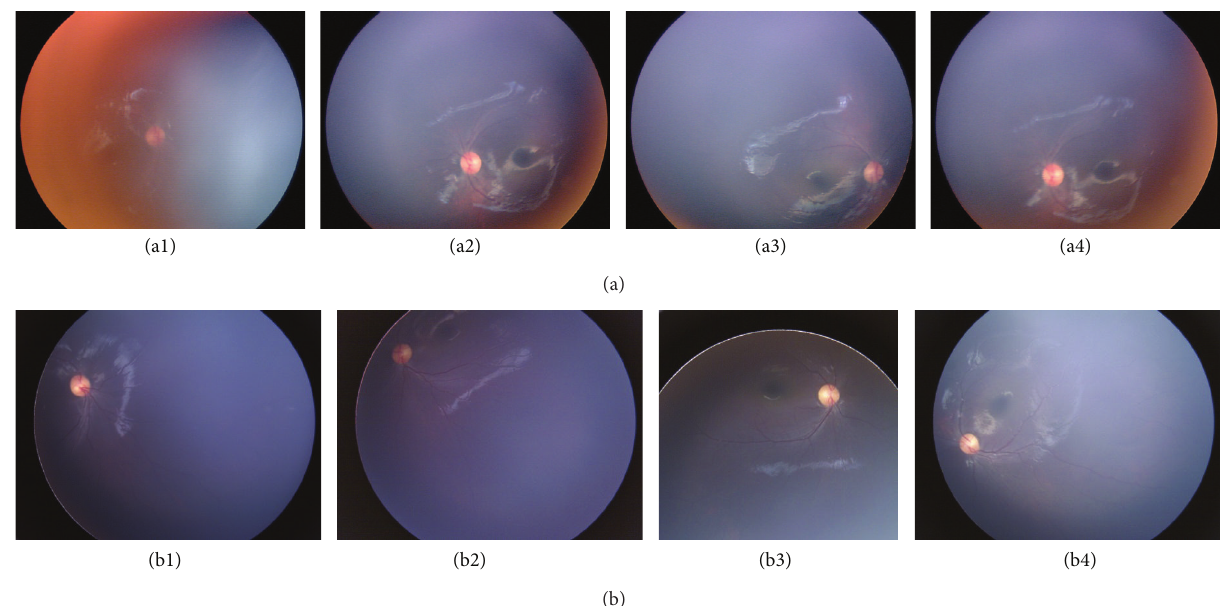
Figure 2: Fundoscopic photographs of twins affected by Leber congenital amaurosis. When the twins (II-1 and II-2) were 11 months old (II-1 right eye: (a1), II-1 left eye: (a2), II-2 right eye: (a3), and II-2 left eye: (a4)), they had mild retinal pigment epithelium changes around the optic disc and slight narrowing of the retinal vessels. Neither pigmentary changes nor macular degeneration were observed in either twin. When the twins were 29 months old (II-1 right eye: (b1), II-1 left eye: (b2), II-2 right eye: (b3), and II-2 left eye: (b4)), no further retinal changes had